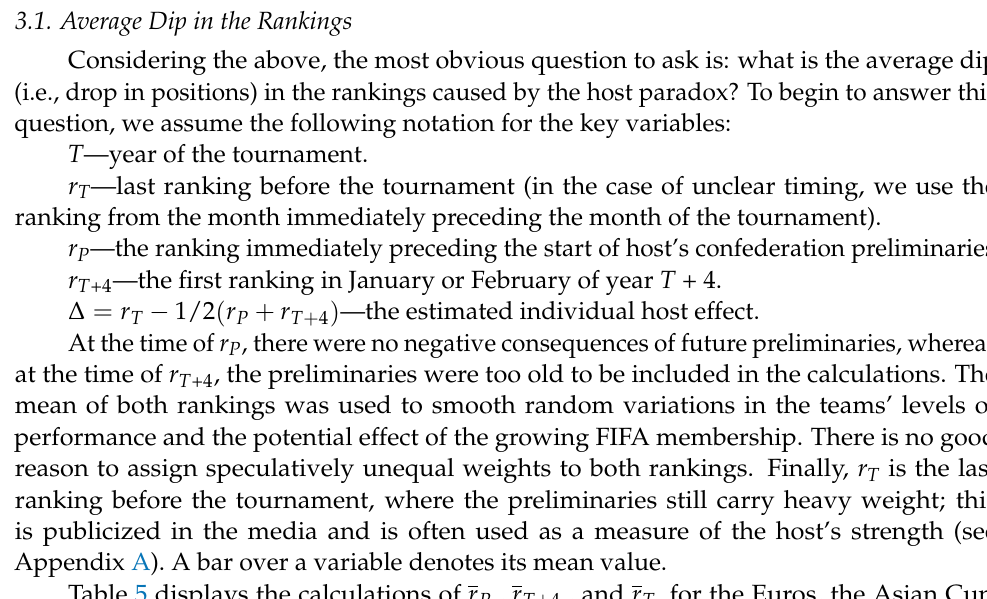
Table 5. The average positions and changes in the FIFA rankings for the hosts of major tournaments since 1994. Tournament Number of Hosts All major Euros World